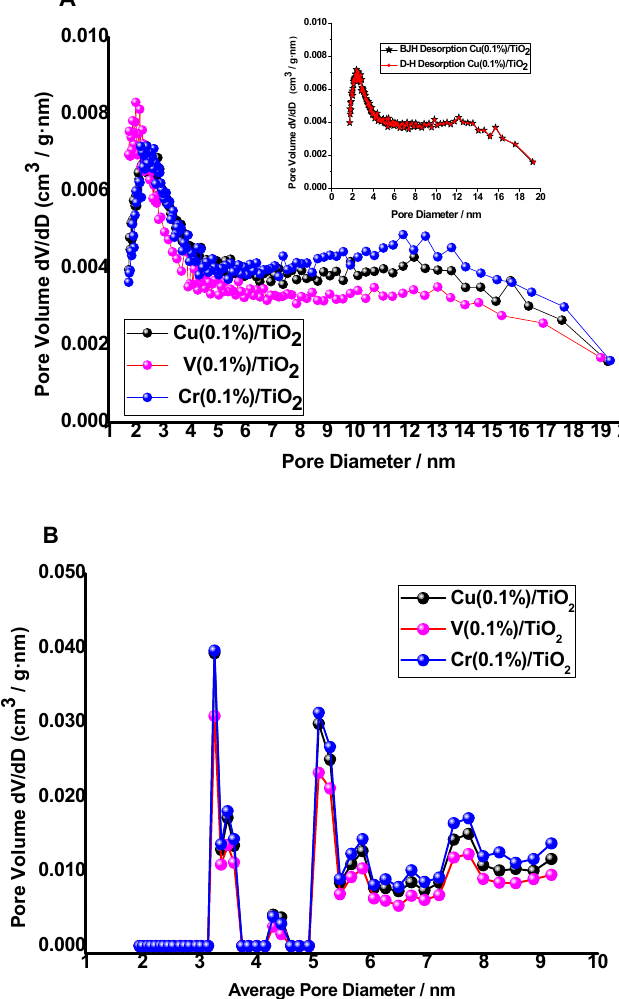
Figure 7. Di ff erential specific pore volume vs. pore width distribution. ( A ) Barrett, Joyner, and Halenda (BJH) model using desorption branch. Inset: Comparison using BJH and D–H models (desorption). ( B ) 2D-non-local density functional theory method (NLDFT) model (N 2 -Carbon Finite Pores, Aspect Ratio 6, Standard Slit).